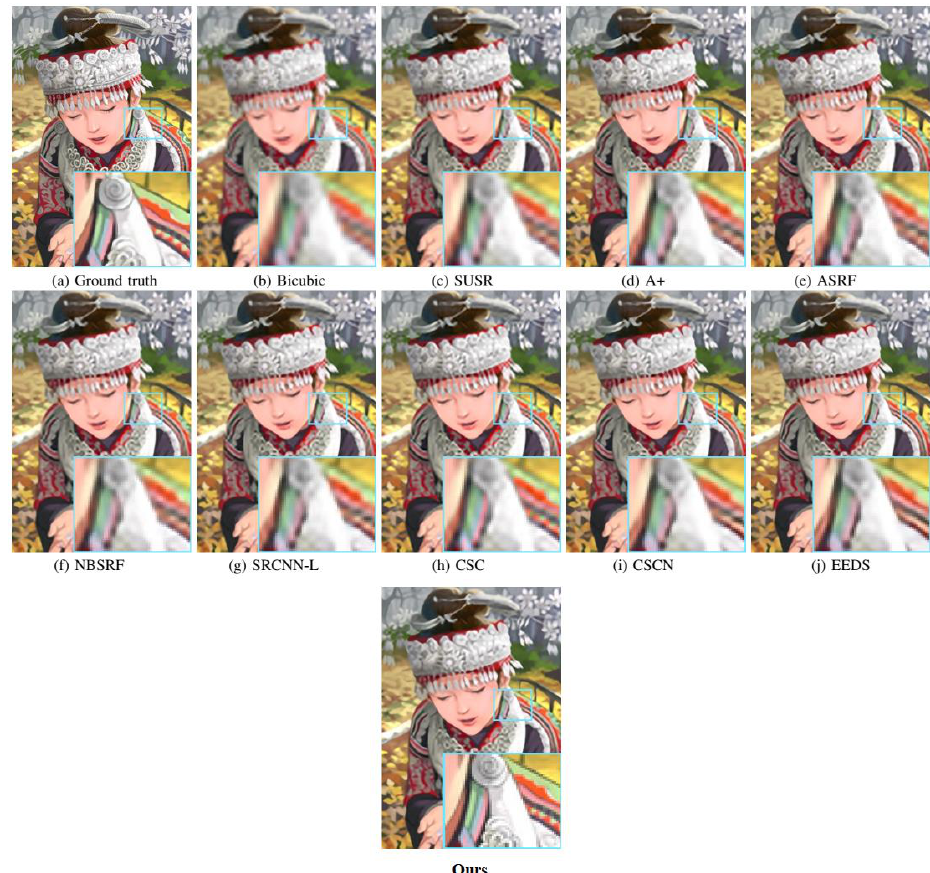
Figure 5. The “comic” image from Set 14 with an upscaling factor of 3.